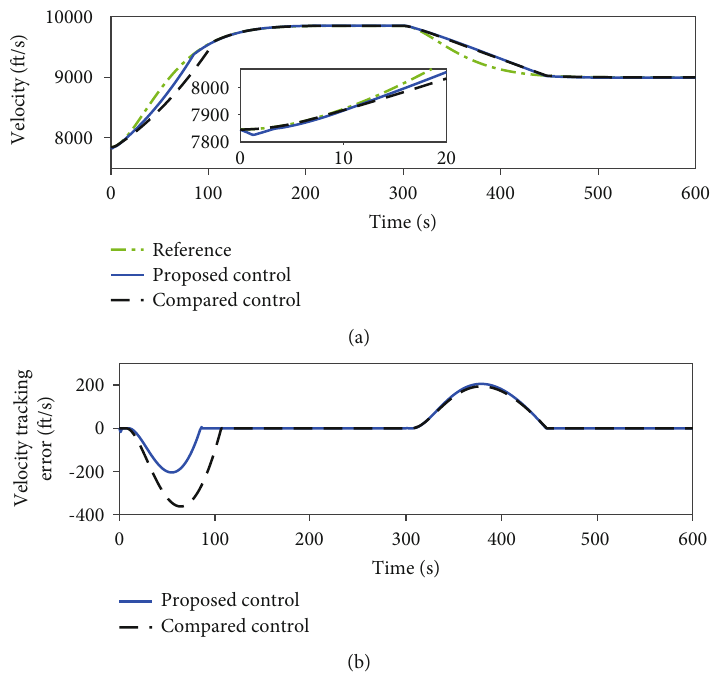
Figure 1: Velocity tracking results in the comparison simulation: (a) velocity tracking; (b) velocity tracking error.